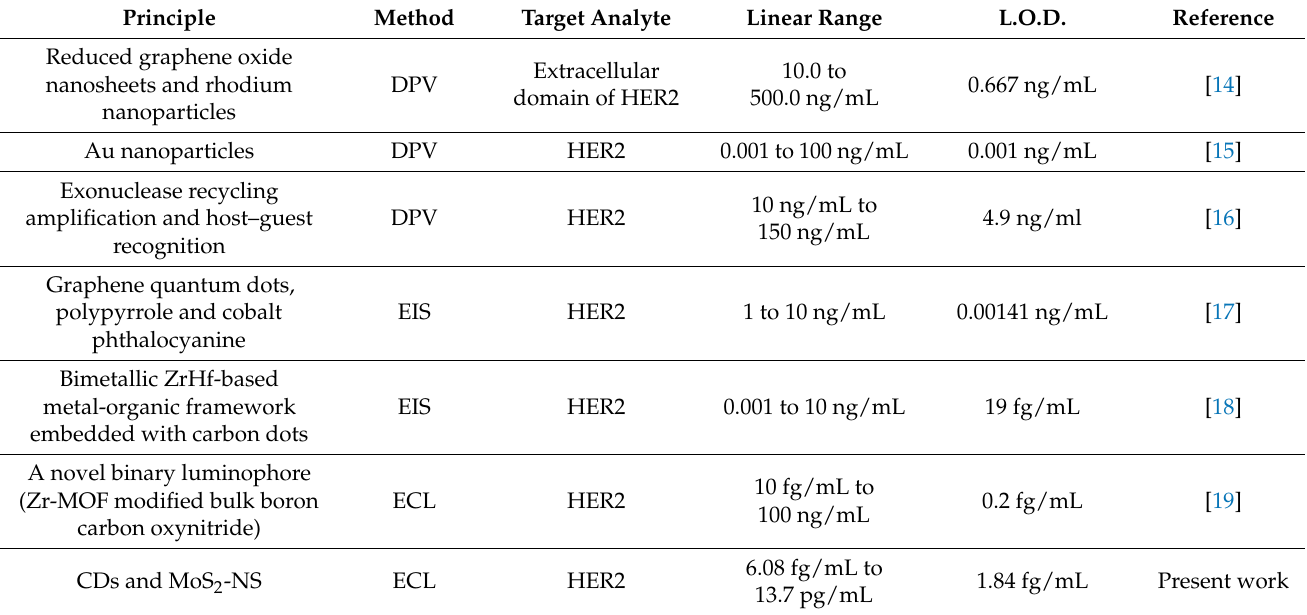
Table 2. Electrochemiluminescence (ECL) and electrochemical aptasensors for human epidermal growth factor receptor 2 (HER2) detection.